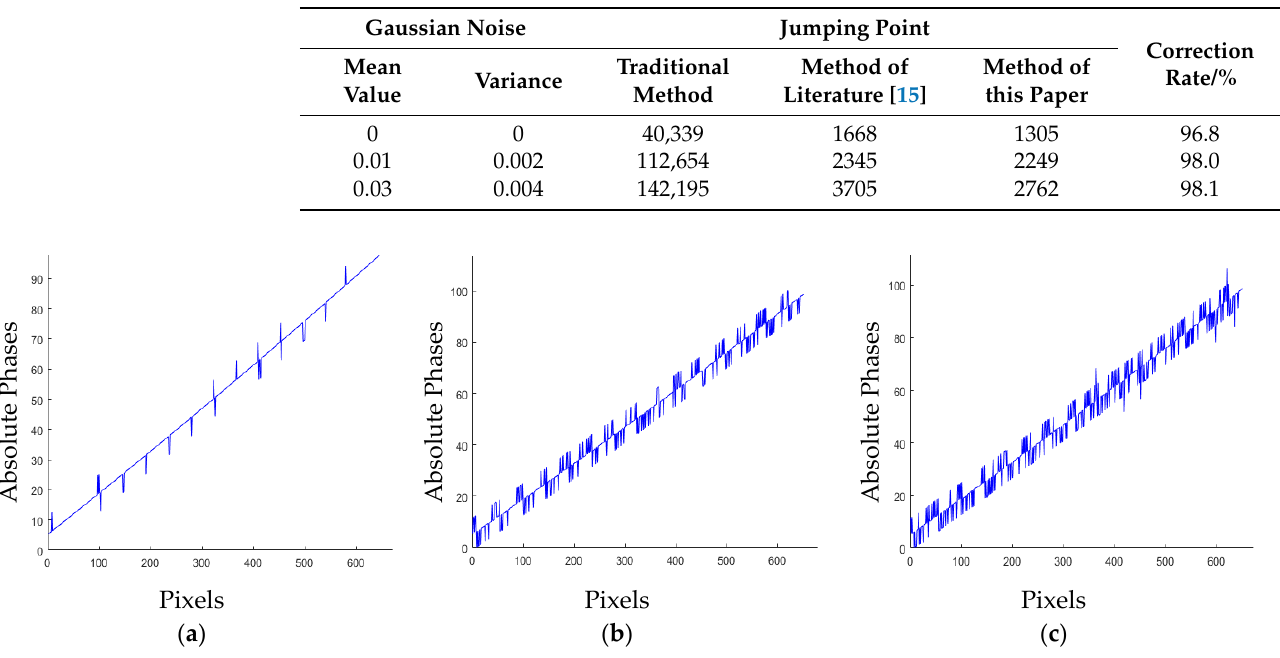
Figure 2. Phase unwrapping by the traditional method under different noises. Phase expansion by conventional method when Gaussian noise is not added ( a ). Traditional method of phase expansion when adding the first set of Gaussian noise ( b ). Traditional method of phase expansion when adding the second set of Gaussian noise ( c ).